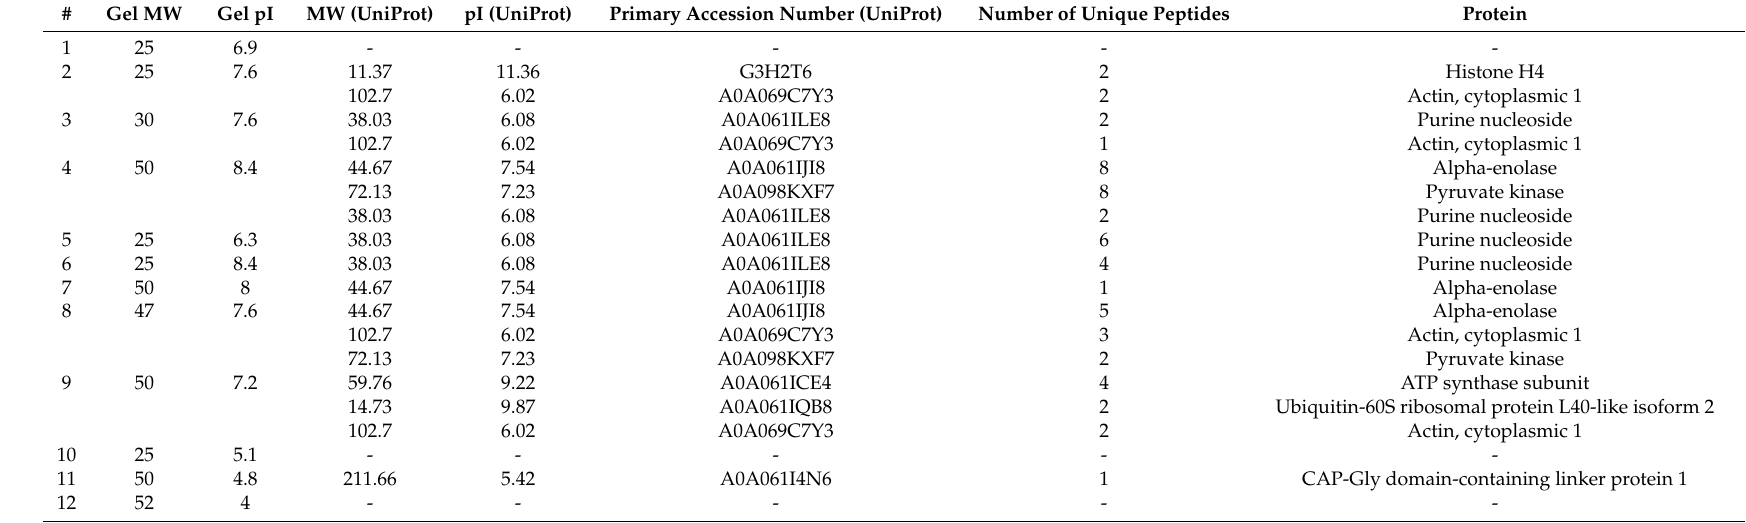
Table A3. Peptides and their corresponding proteins identified via LC-MS/MS in spots of 2D gel of the HIC fraction. Molecular weight (MW) and isoelectric point (pI) of the unmodified full length protein according to